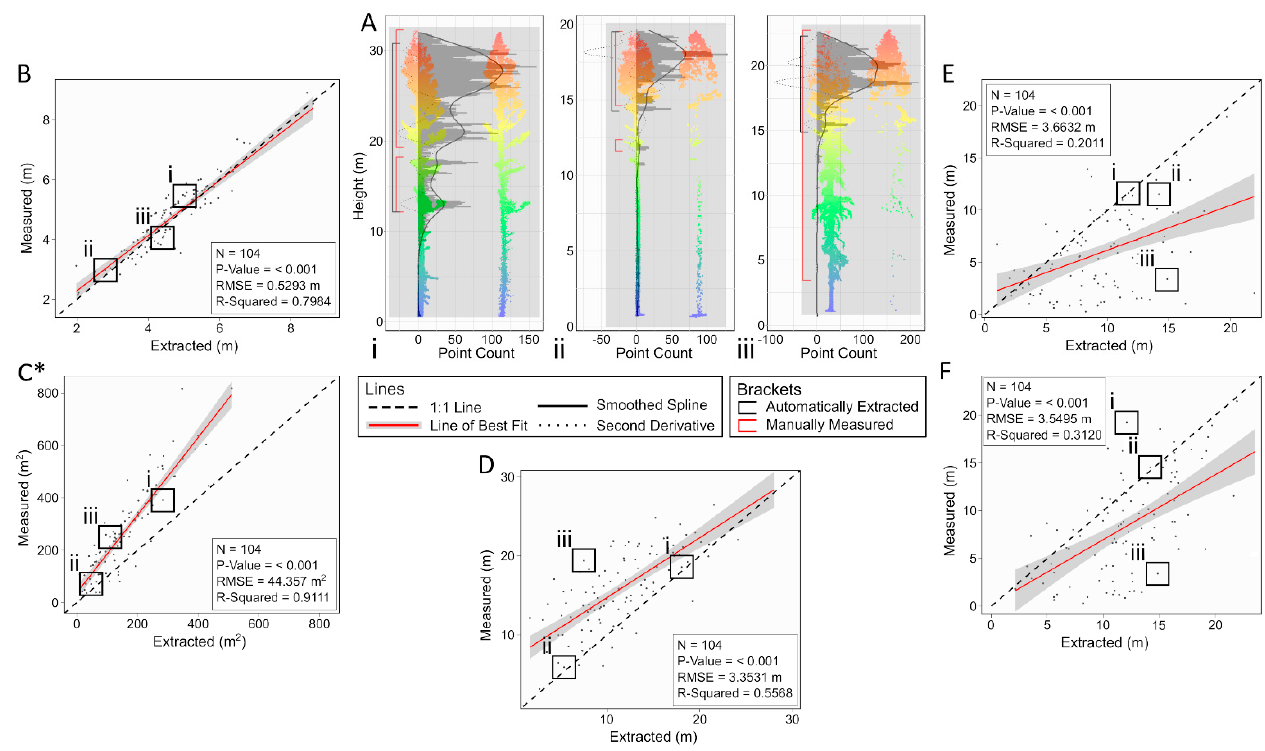
Figure 8. Tree-level point clouds and agreement between extracted and measured values for five metrics. ( A ) Point clouds (left—MLS, right—RPAS LiDAR), histograms, and merged live branch clusters for three example trees (i, ii, iii). Agreement between measured and extracted ( B ) crown width; ( C* ) total live branch volume (the points of 2 large trees were removed for display purposes); ( D ) live crown length; ( E ) lowest live branch height; ( F ) live crown base height.